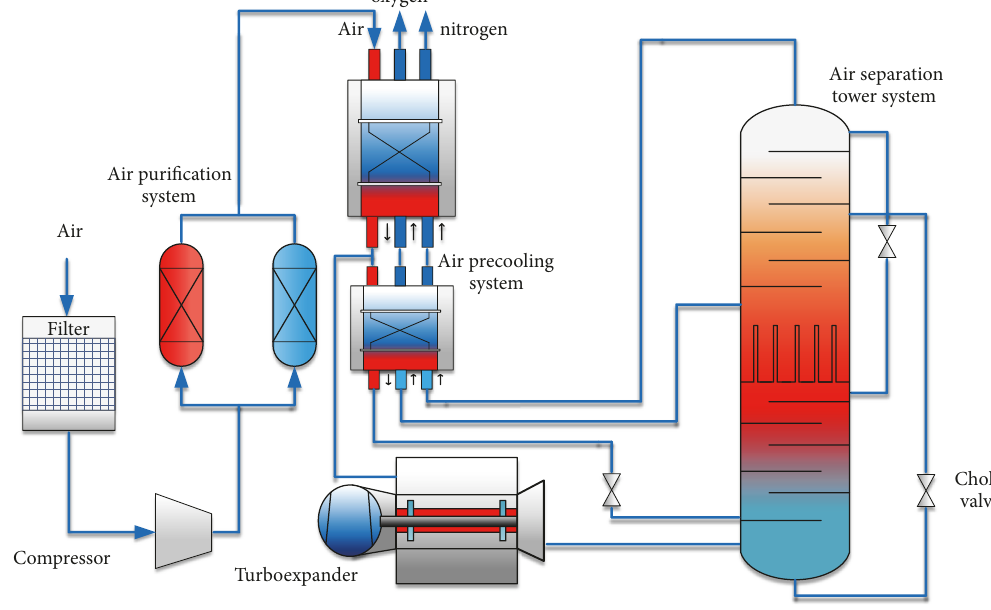
Figure 4: Air separation distillation section.